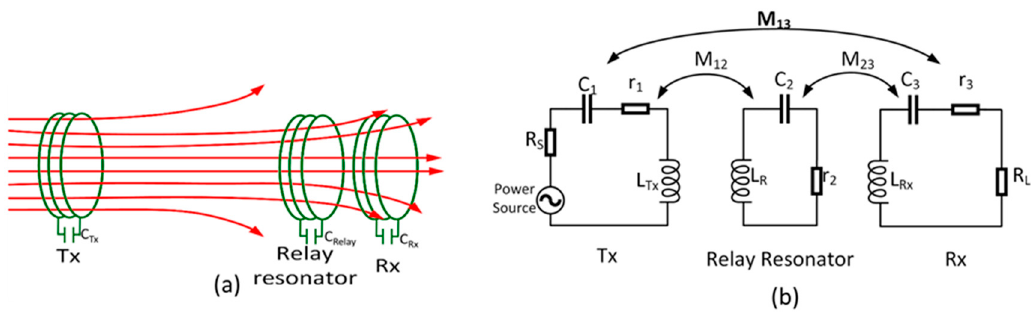
Figure 2. ( a ) The enhanced multiplication system with relay resonator and ( b ) its equivalent circuit model for energy harvesting system.